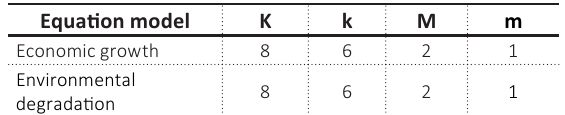
Table 2. Problem identification with order